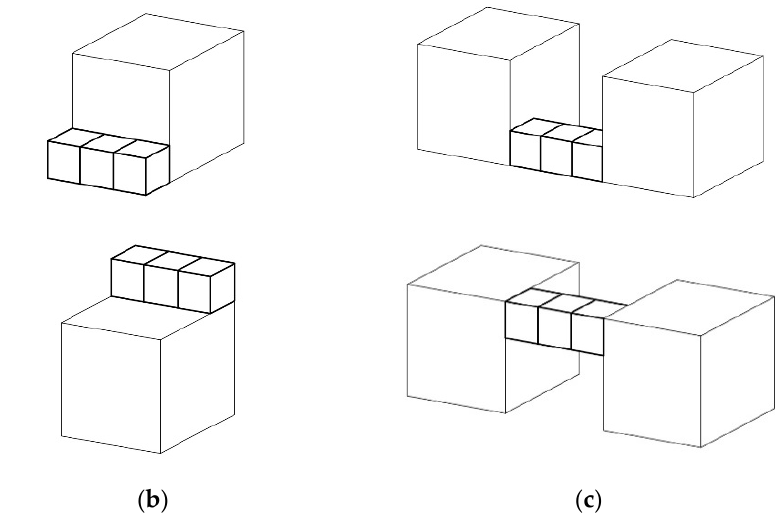
Figure 4. Typology of the all-glass structure by functional-spatial aspects: ( a ) pavilions; ( b ) extensions; and ( c ) links (figures by the author).